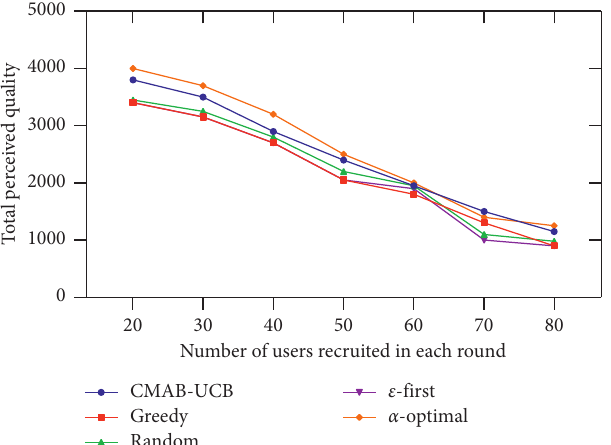
Figure 7: The relationship between perceived quality and the number of recruited users ( b � 10000).